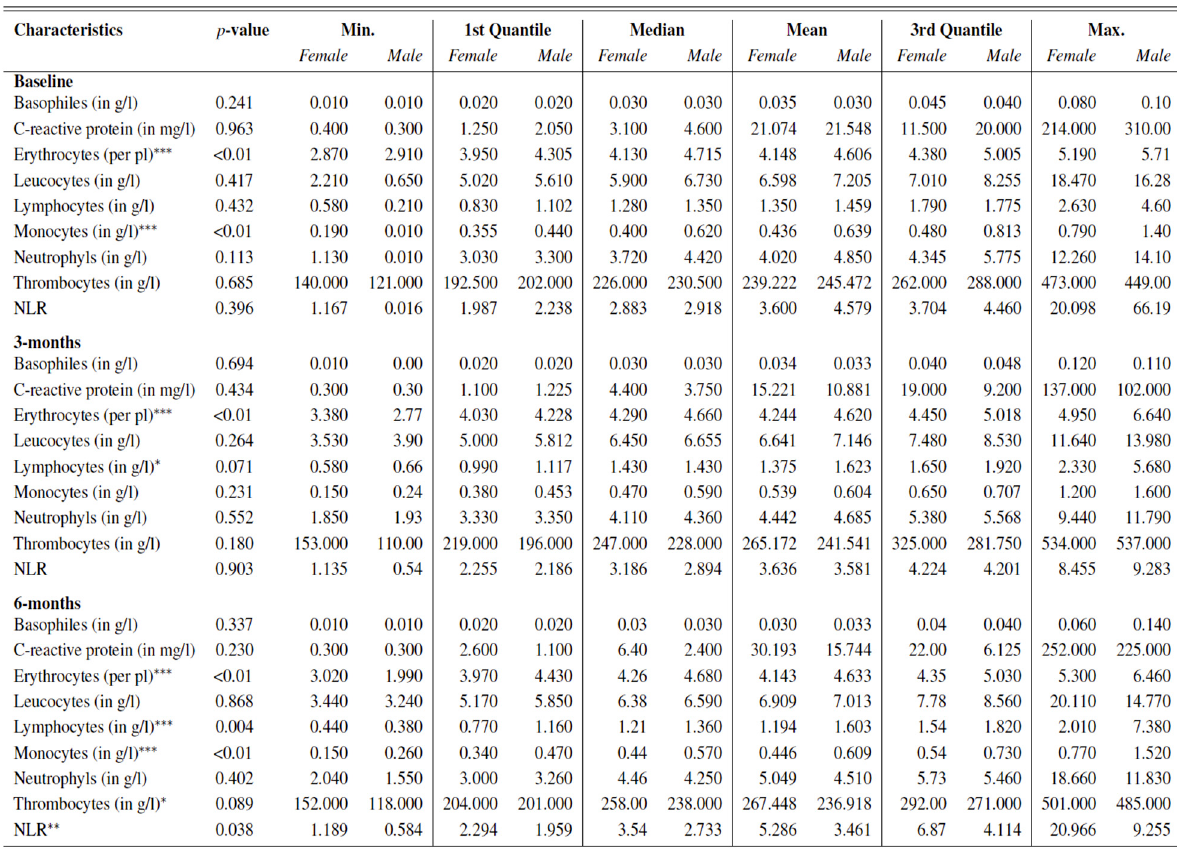
Figure 2. Blood parameters of all included female and male patients with advanced melanoma treated with ICI at baseline, and three and six months after treatment start.